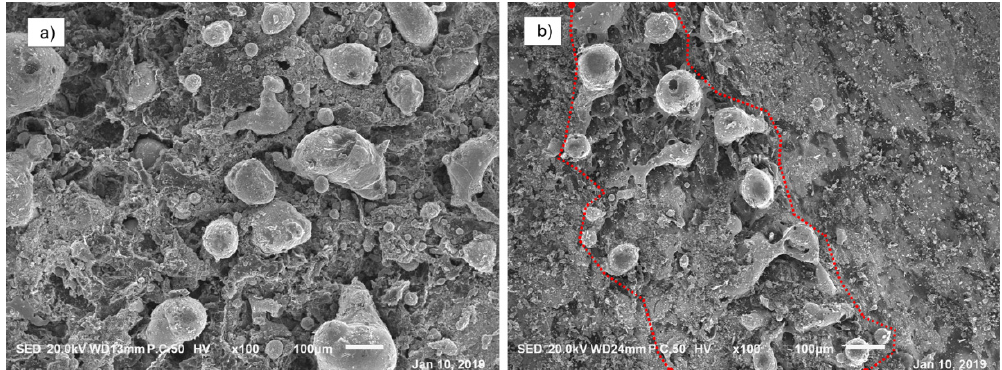
Figure 9. SEM photography of current-carrying wear surface of copper-graphite composites: ( a ) the picture of the large area of arc erosion, ( b ) the picture of the local area of arc erosion.